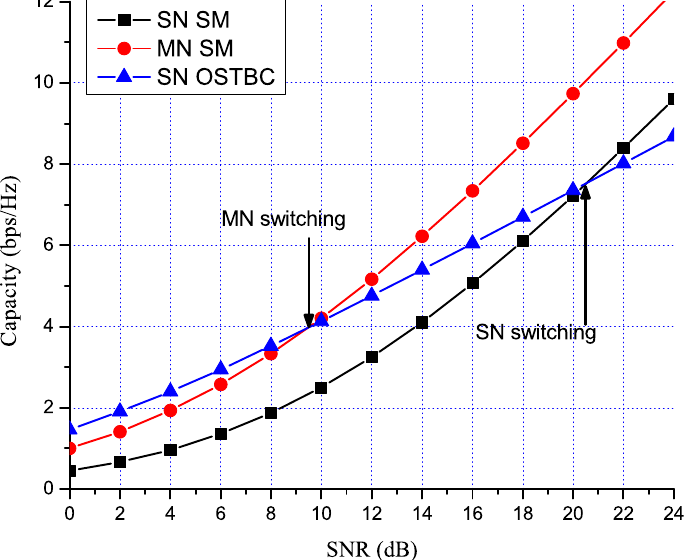
Figure 7. MIMO 2 × 2 capacity with high spatial correlation ( η = 0 . 8 , µ = 0 . 9 ).